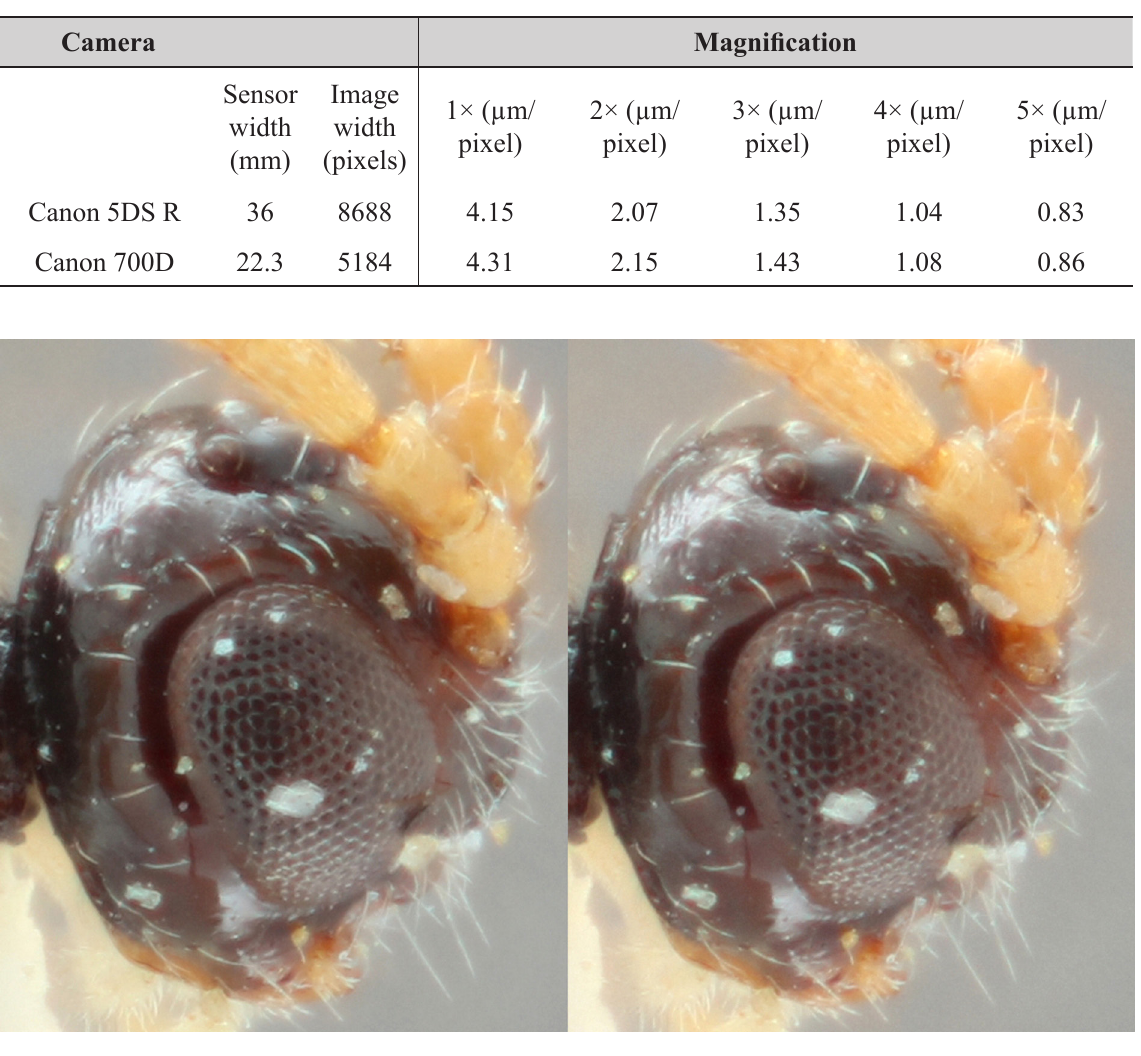
Table 2.2. Equipment list needed to perform photogrammetry of small